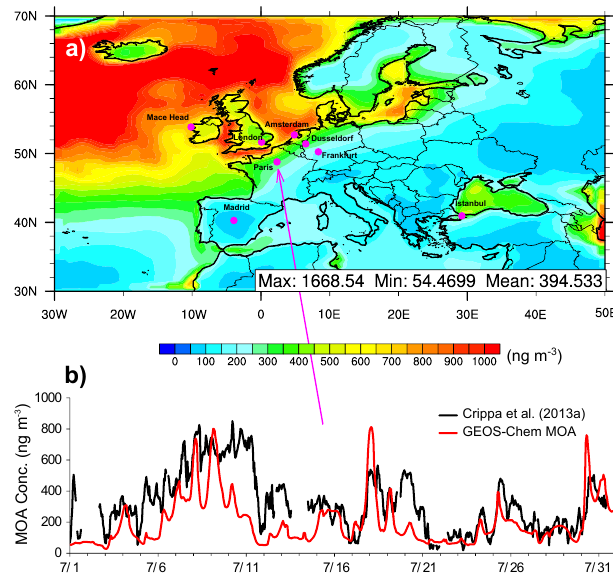
Figure 2. (a) Average submicron surface concentration of MOA for July 2009 in the nested Europe GEOS-Chem domain and the (b) time series of the observed and predicted marine organic aerosol concentration near Paris, France, as reported by Crippa et al. (2013a). Evaluation of the GEOS-Chem MOA with the Crippa et al. (2013a) observations gives a correlation coefficient of 0.62, mean bias of − 120ngm − 3 , and normalized mean bias of −